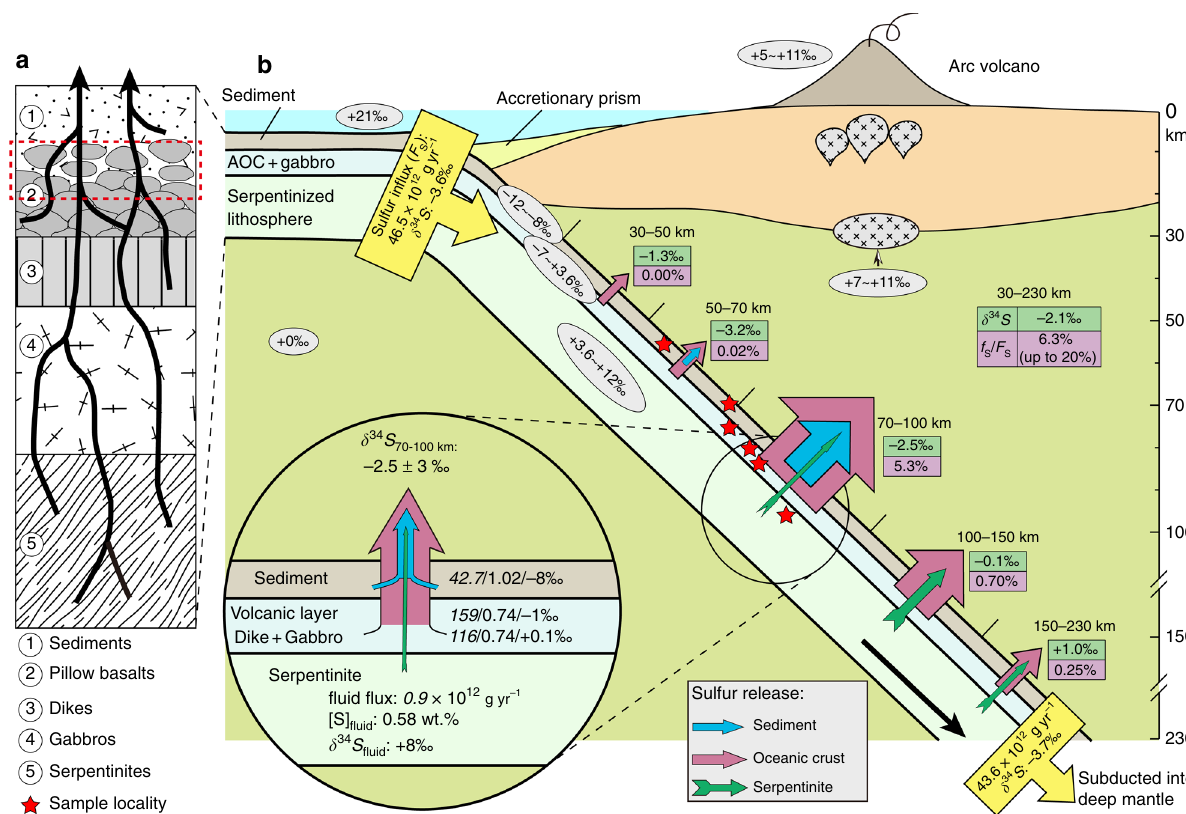
Fig. 9 Diagram illustrating fl uid-mediated sulfur release in the subduction zone. a Schematic lithologic succession of typical subducted oceanic lithosphere. The bold arrows refer to channelized fl uid fl ow, and the dashed rectangle refers to the sequences of this case study in the Tianshan. b Estimated sulfur fl ux (arrow sizes represent the relative sulfur amounts) and isotope compositions released from the subducting slab at different depths via fl uid fl ow. Inset circle shows the key parameters during net δ 34 S calculation of slab fl uids to sub-arc mantle, such as global H 2 O fl ux, sulfur concentration and isotopic composition of fl uids derived from different sequences of the subducting slab. f S /F S ratio of 20% is the maximum value from DEW results. Numbers in ellipsoids refer to bulk sulfur isotope compositions in reservoirs of subduction settings (data sources see text). Red stars represent the depths of metasediments, metabasites (including veins) and serpentinites in this study formed in the subduction zone. Not to scale. Source data are provided in Supplementary